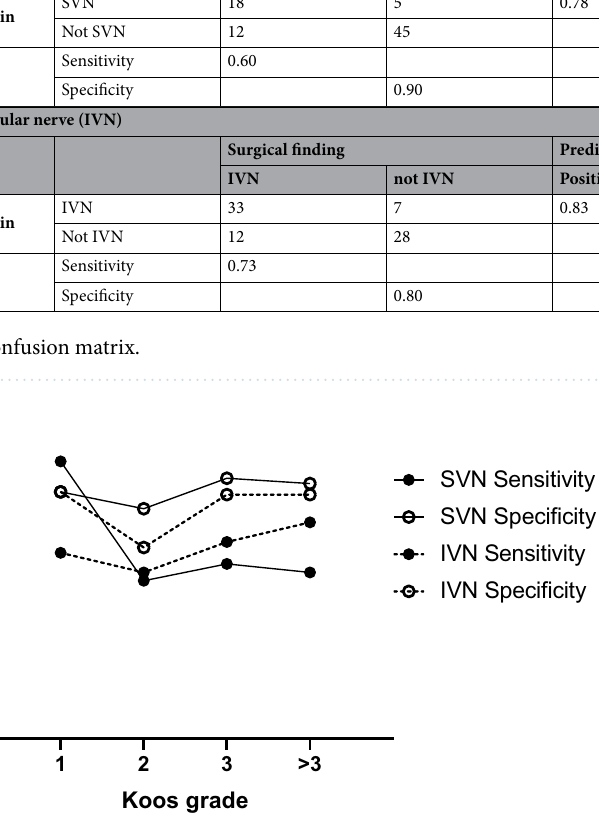
Figure 2. Sensitivity and specificity of the nerve of origin prediction by the scoring system stratified by Koos grade.